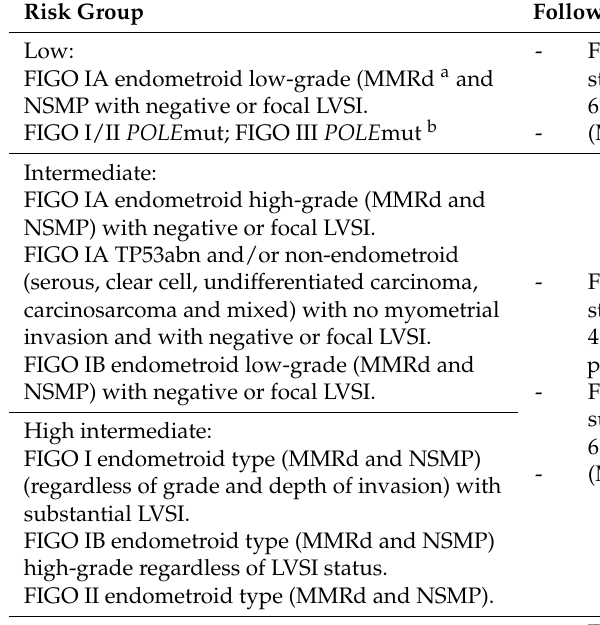
Table 7. Recommended post-treatment follow-up schedule for patients with endometrial cancer. Risk